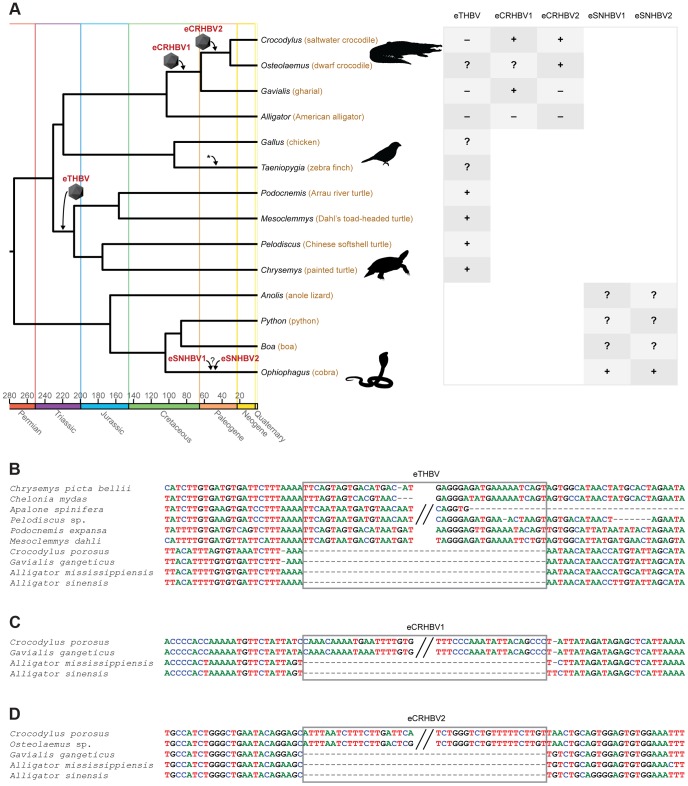
Non-avian hepatitis B paleovirus endogenization events.(A) Simplified chronogram of non-mammalian amniotes based on molecular dates of phylogenetic relationships among amniotes [40], squamate lepidosaurs [78], [79], turtles [39], birds [80], and crocodilians [42], [43]. Icosahedrons denote endogenization events, the asterisk indicates previously studied avian endogenizations [10], and the colored time axis corresponds to the International Stratigraphic Chart (http://www.stratigraphy.org/ICSchart/StratChart2010.pdf). All HBV EVE endogenization events were reconstructed based on their respective presence/absence patterns (“+”: presence, “−” absence; “?”: missing data or sequence could not be aligned). This is with the exception of cobra eSNHBVs where we could not ascertain presence/absence states in other squamates. The early Mesozoic eTHBV paleovirus (B) is present in orthologous locations in both pleurodiran and cryptodiran turtles, but absent in crocodilians. All crocodilians to the exclusion of the alligator (i.e., Longirostres [41]) share the Cretaceous eCRHBV1 insertion (C), while the Paleogene eCRHBV2 insertion (D) is present in saltwater and dwarf crocodile (i.e., Crocodylidae), but absent in orthologous positions in gharial and alligator. HBV-derived sequence residues are boxed.